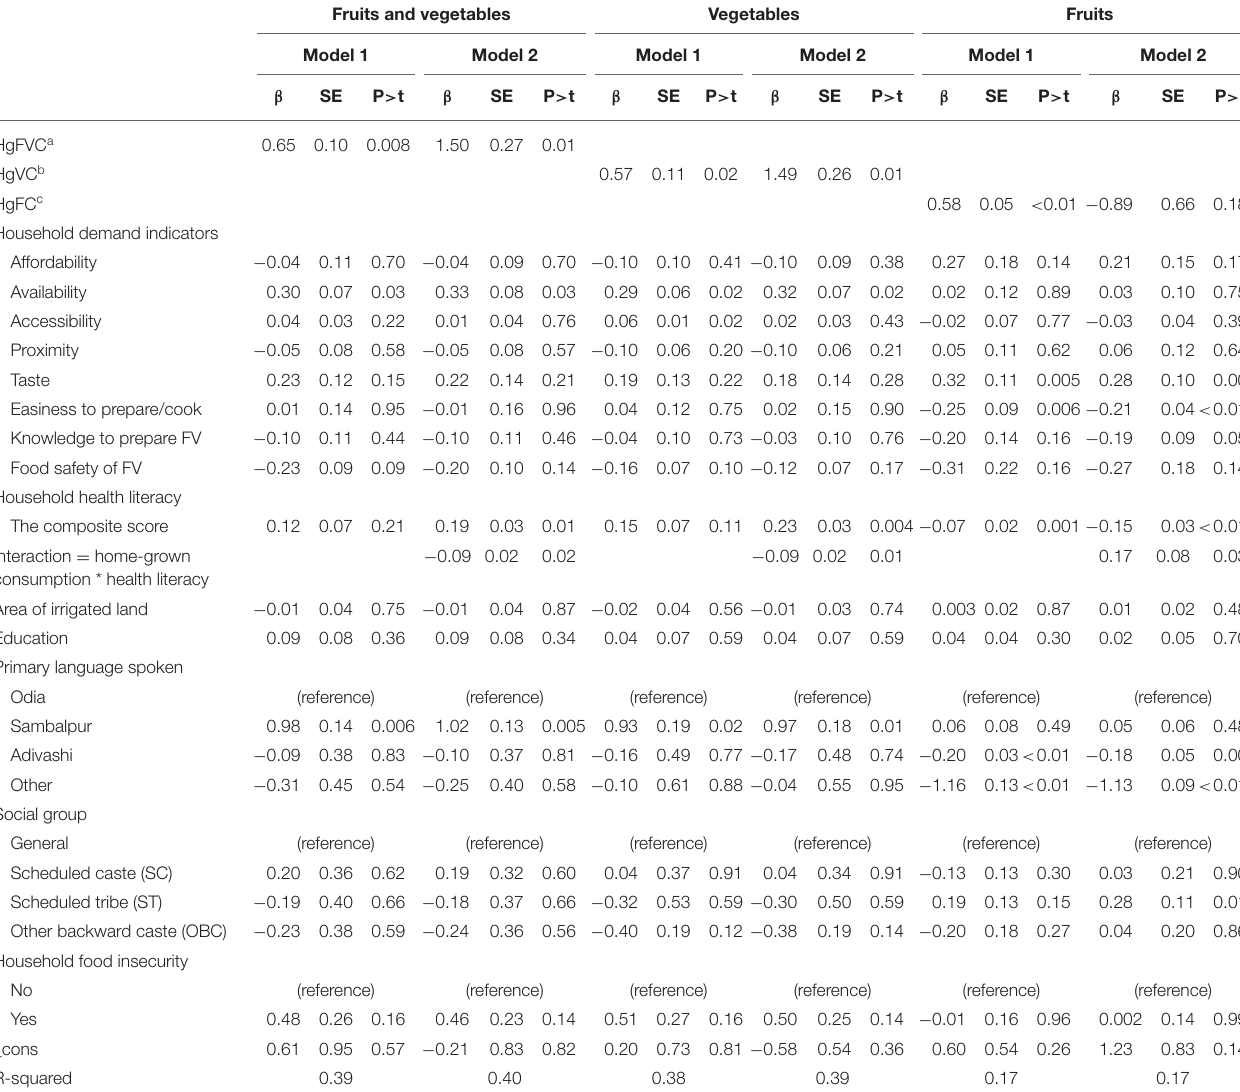
TABLE 2 | Multivariable model analyses for daily servings per capita of fruits and vegetables , vegetables only , and fruits only . Fruits and vegetables Vegetables